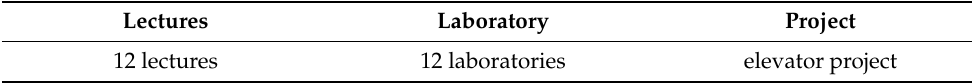
Table 1. The organisation of the course